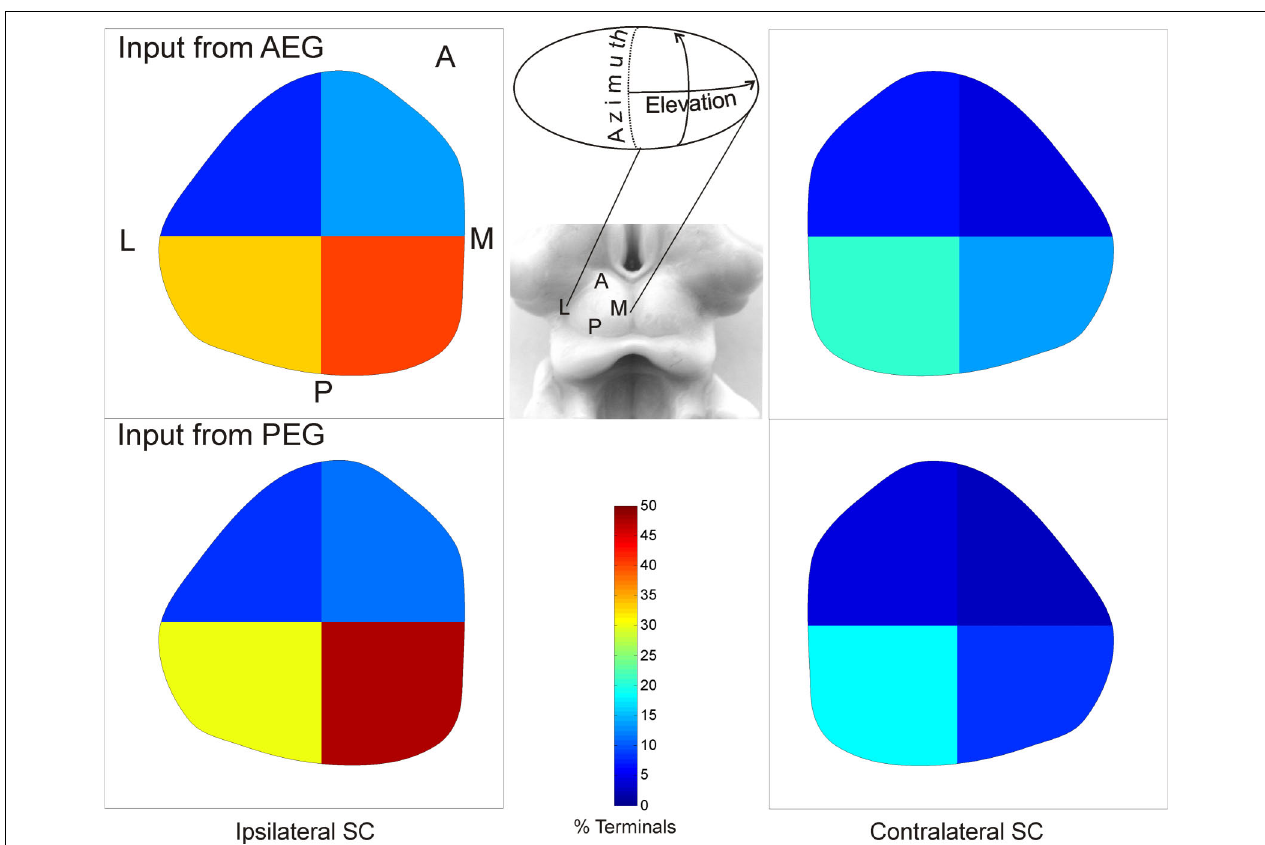
FIGURE 6 | Distribution of cortical terminals in the SC. The proportion of terminals is plotted after dividing the SC into quadrants. The highest proportion was found in the posterior half of the SC, especially in the medial quadrant (ANOVA, F = 9.865, p = 0.001), and no differences in this distribution were found with (3,3) injection site location in the cortex (ANOVA, F = 0.008, p = (1,3)